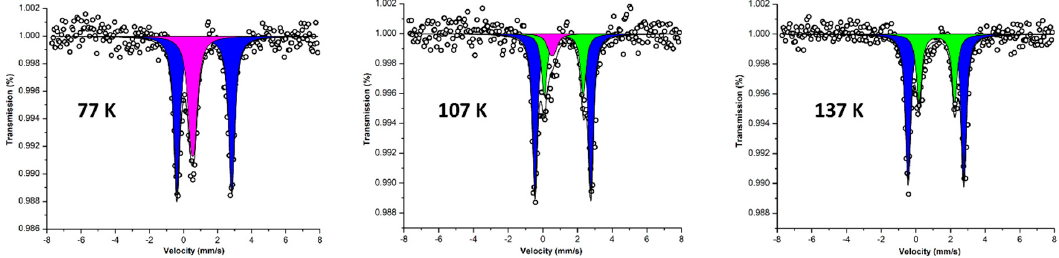
Figure 11. Mössbauer spectra of compound 2 at 77 K, 107 K and 137 K. The open circles are the experimental data, the black solid line shows a superposition of the following components: subspectrum 1 (purple) represents the [LS] fraction of central iron (Fe2), subspectrum 2 (blue) is due to the [HS] fraction of terminal iron (Fe1 and Fe3), and subspectrum 3 (green) is the [HS] fraction of central iron (Fe2). Parameters see Table 2.